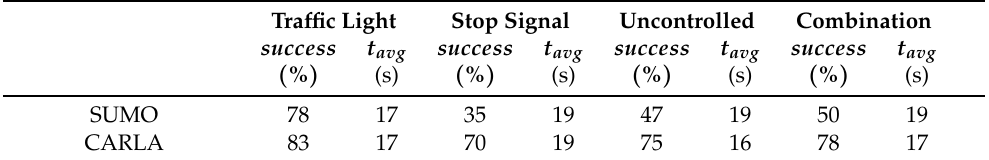
Table 3. Evaluation metrics results in CARLA simulator: comparison between the model trained in SUMO (2-FEPPO) and the model trained in CARLA (SUMO + CARLA).